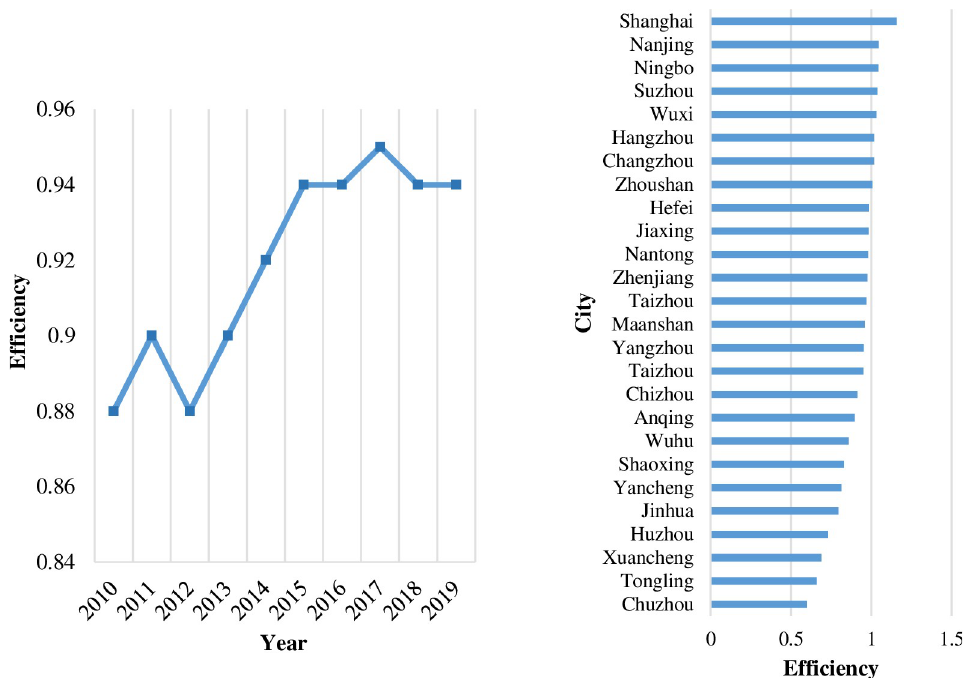
Fig 3. Efficiency measurement results of the integrated transport in the Yangtze River Delta. The data above are calculated by MYDEA 3.0. Taizhou, which is ranked 13, is in Jiangsu province, and Taizhou, which is ranked 16, is in Zhejiang